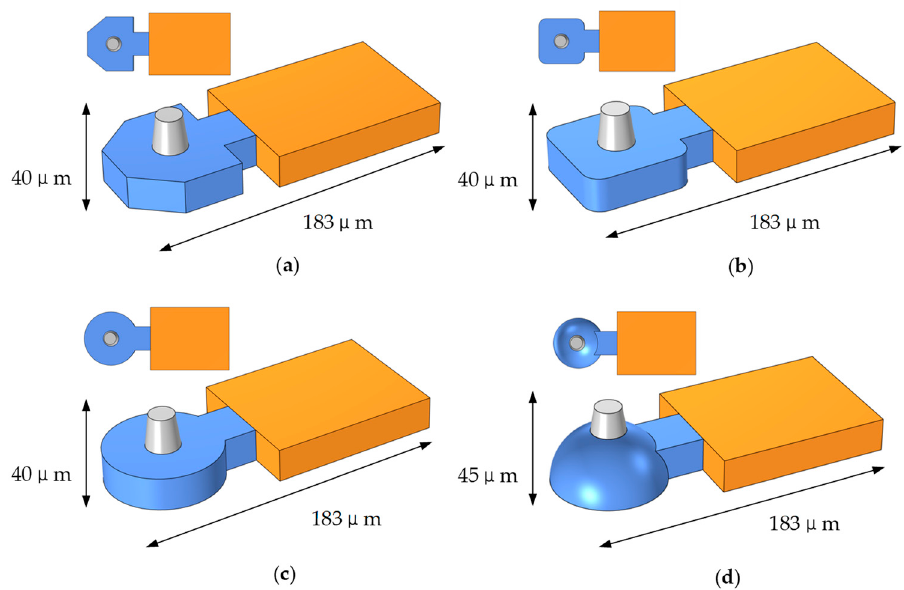
Figure 12. Inkjet head parameters for different chambers. ( a ) Structural parameters of the trapezoidal inkjet head; ( b ) Structural parameters of the square inkjet head; ( c ) Structural parameters of round the inkjet head; ( d ) Structural parameters of the hemispherical inkjet head. Table 2. Comparison of inkjet heads with different